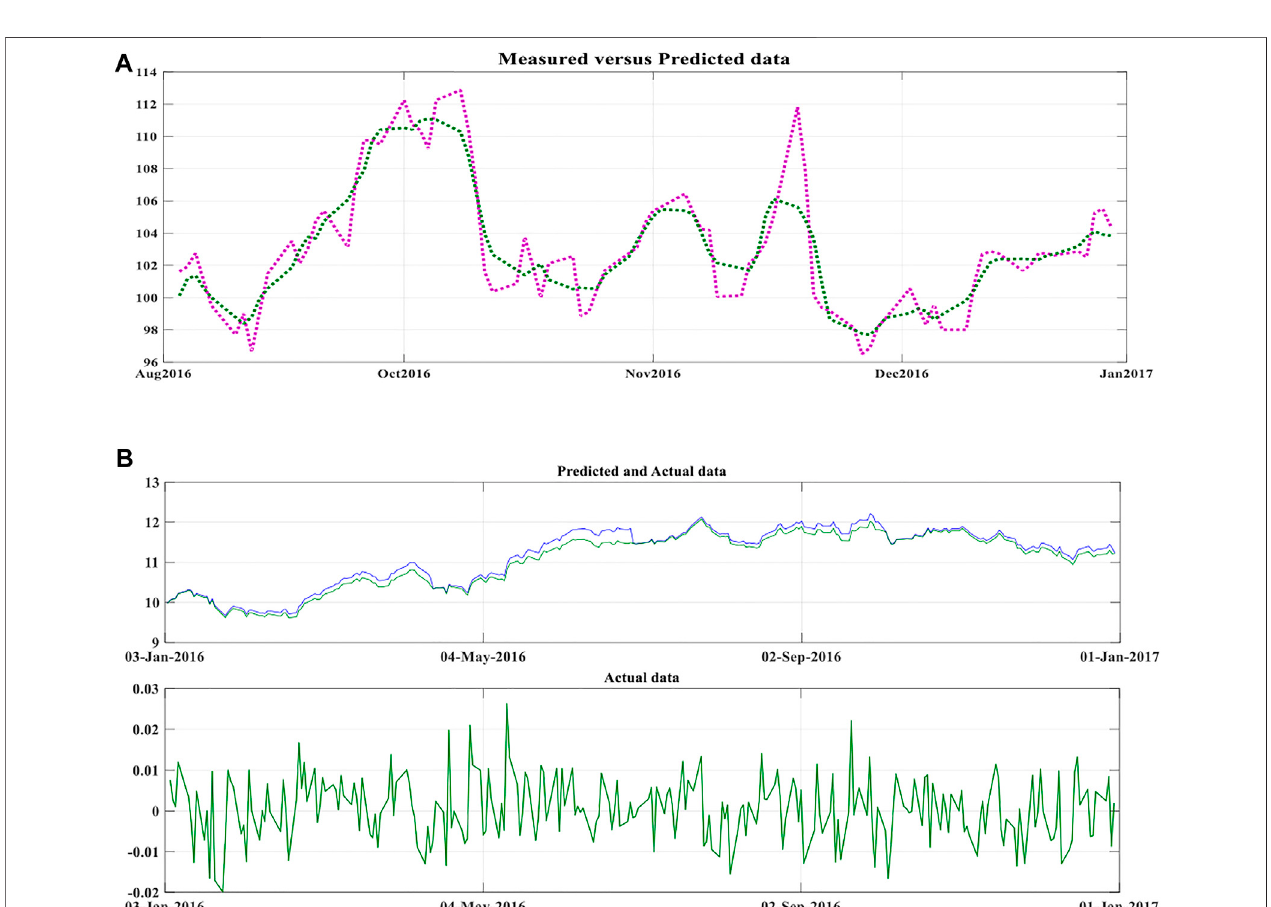
FIGURE 12 | (A,B) ANFIS-based comparison between latest measured and prediction solar